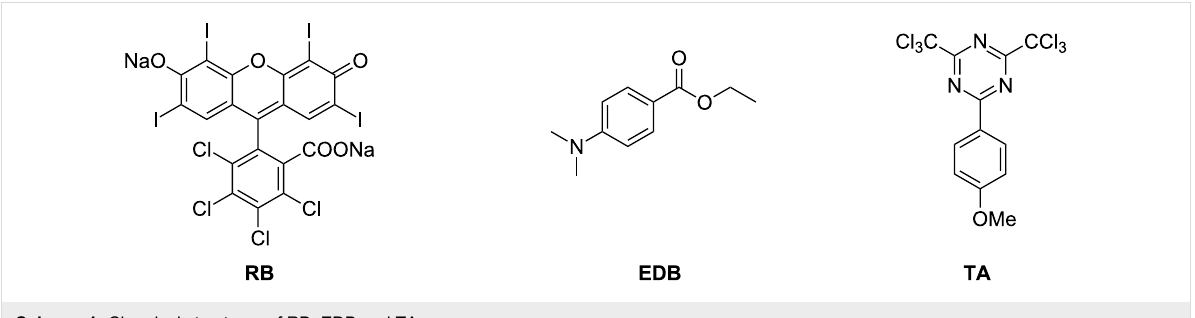
Scheme 1: Chemical structures of RB, EDB and